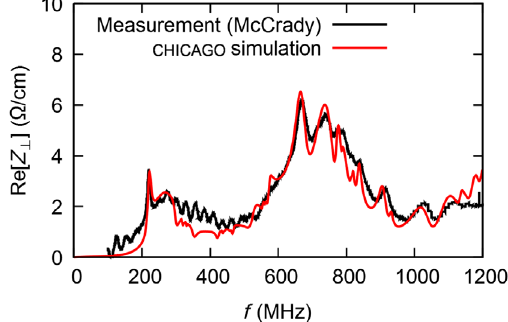
FIG. 14. Comparison of measurement of the perpendicular impedance of PAC test cell to CHICAGO simulation